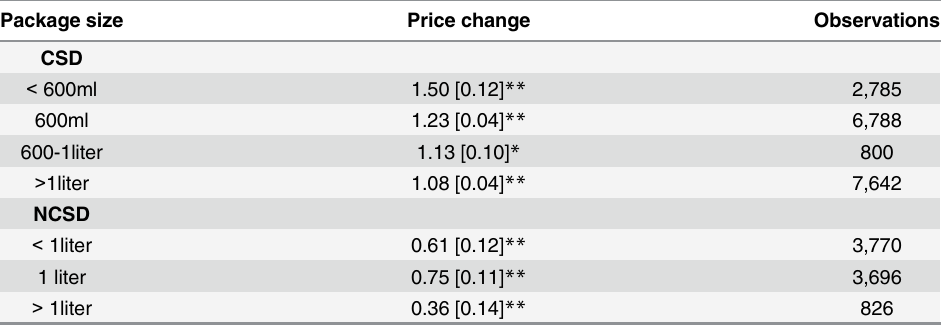
Table 3. Fixed-effect models estimating the change in prices for carbonated sugar sweetened bever- ages (CSB) and non-carbonated sweetened beverages (NCSB) after the excise SSB tax started strati- fied by package